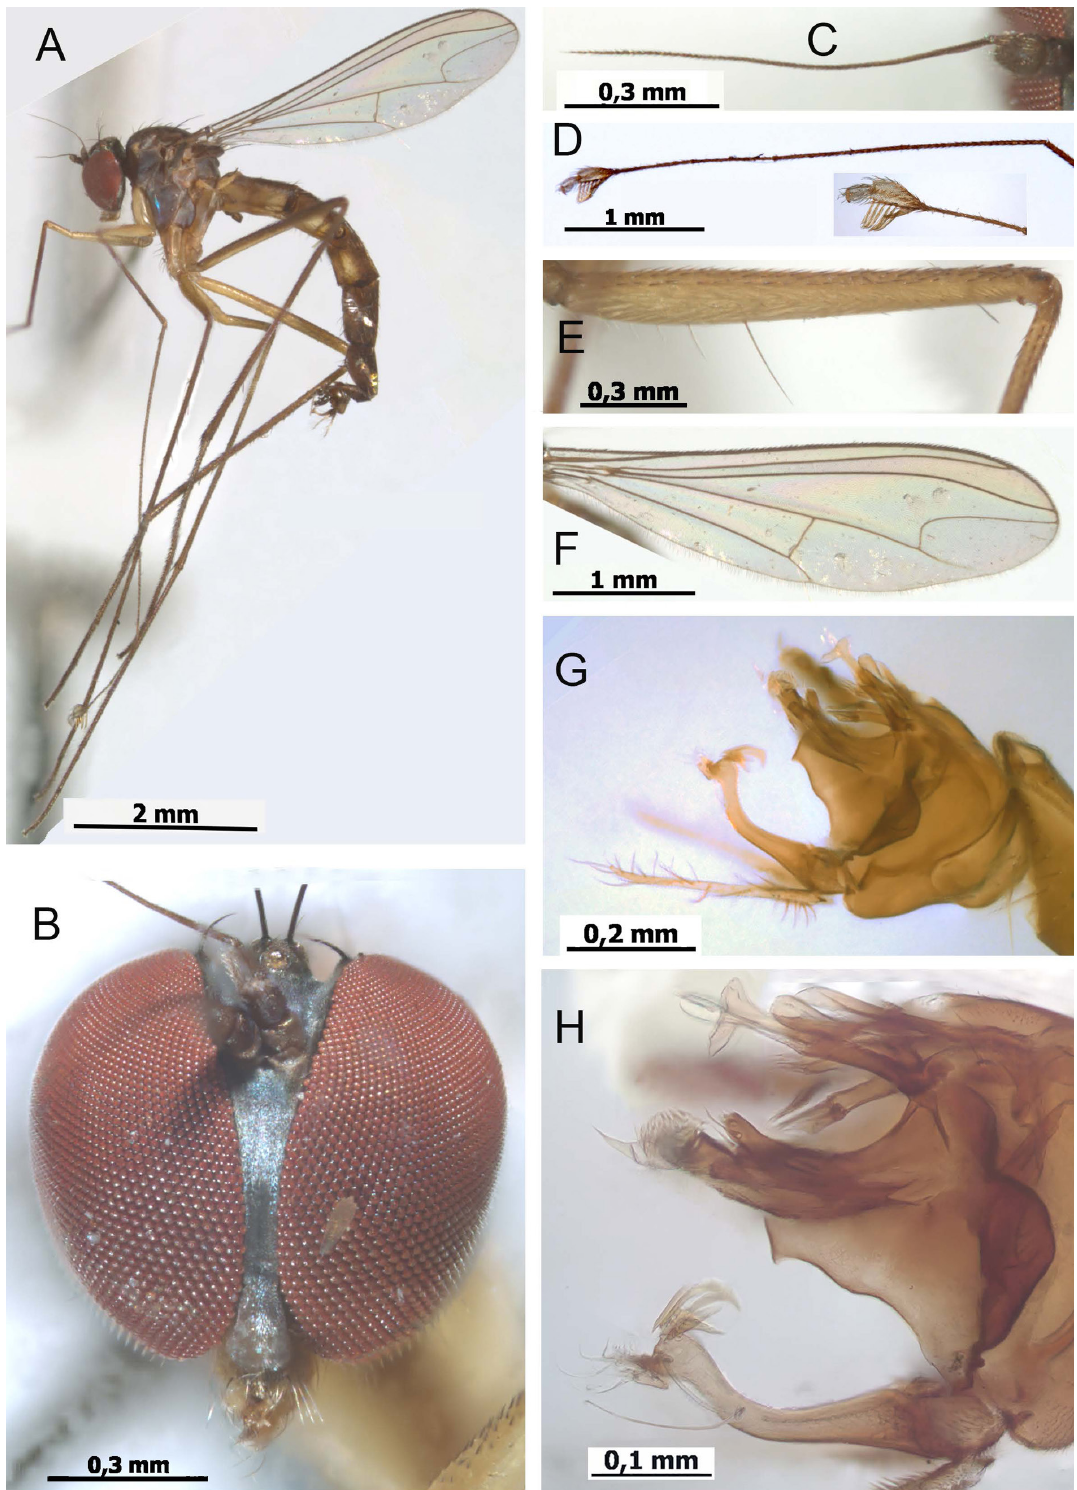
Fig. 9. Amblypsilopus fianarantsoa sp. nov. Holotype, ♂ (SMNHTAU). A . Habitus. B . Head. C . Antenna. D . Fore tarsus, with inset showing segments 3–5, dorsal view. E . Mid femur. F . Wing. G . Hypopygium, left lateral view, reflected light. H . Distoventral appendages of hypopygium, lateral view, transmitted